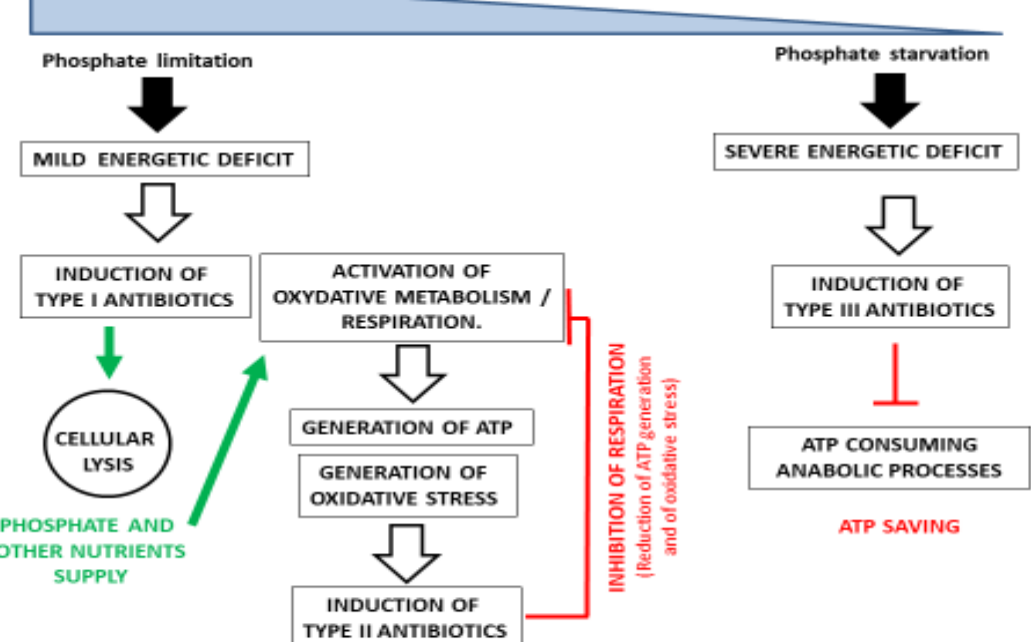
Figure 1. Schematic representation of the role played by each type of antibiotic in the regulation of the energy metabolism of Streptomyces in condition of moderate to severe phosphate limitation.